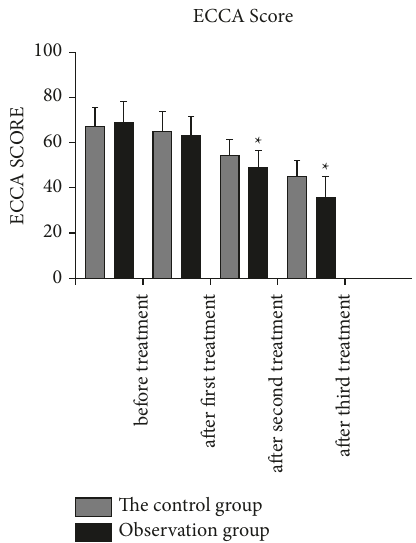
Figure 5: Comparison of ECCA scores between the two groups before and after treatment Note. Compared with the control group, t � 4.184 and 5.629; ∗ P < 0 . 05.